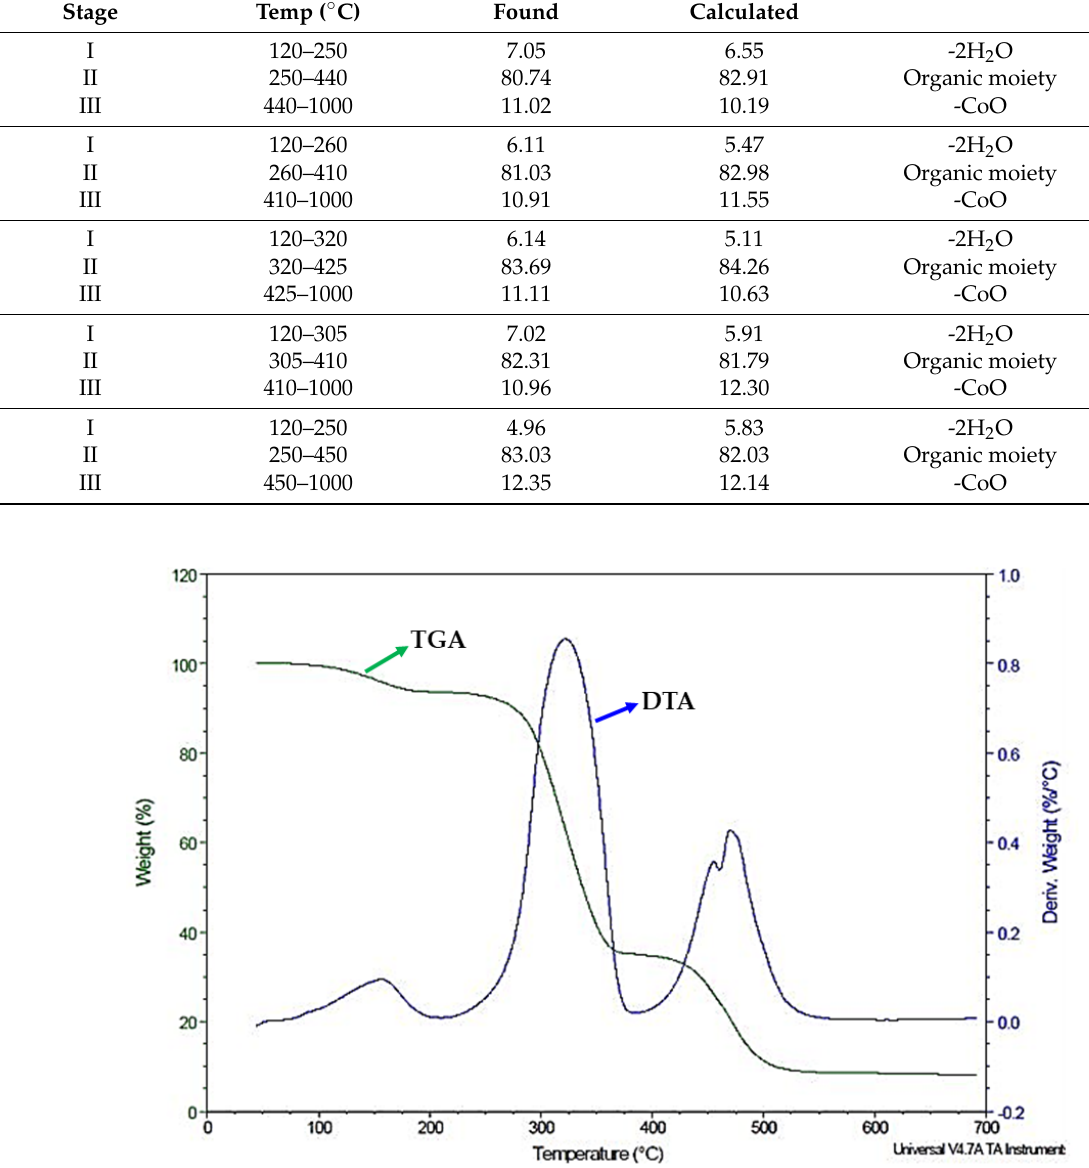
Figure 3. TGA-DTA graph of a C 1